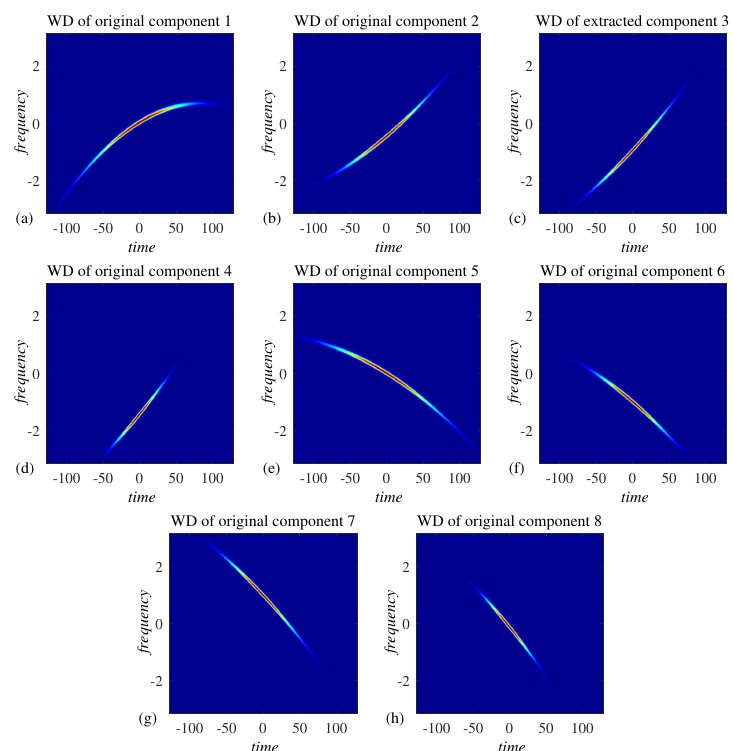
Figure 9. ( a – h ) Original signal components of the non-stationary multicomponent multichannel signal considered in Example 2. Wigner distributions are calculated, each individual, noise free component.